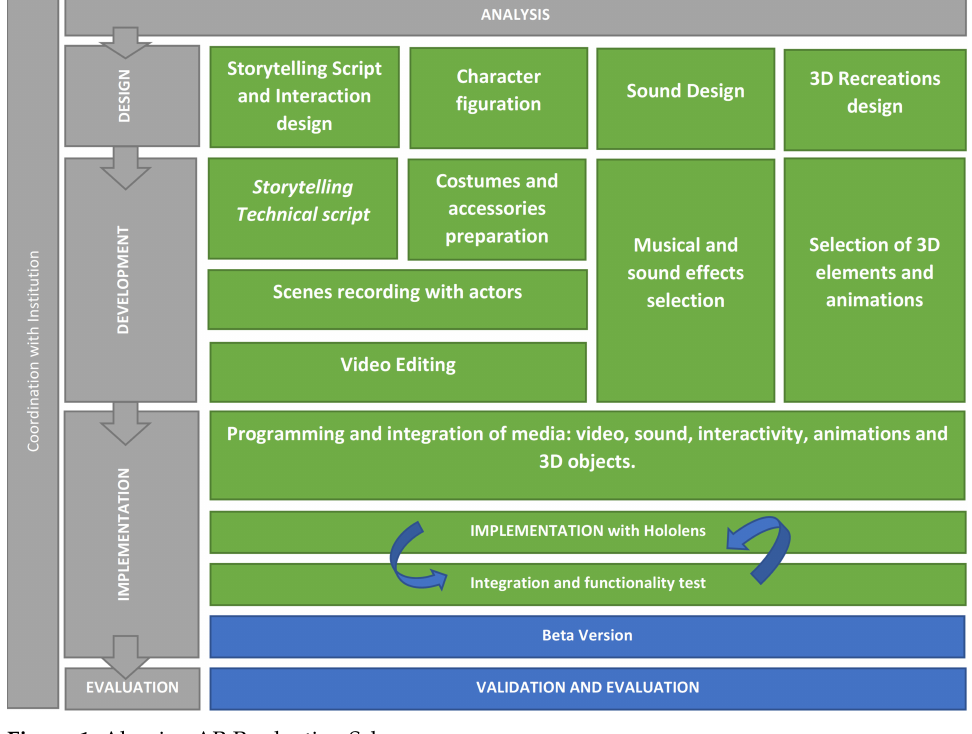
Figure 1. Almoina AR Production